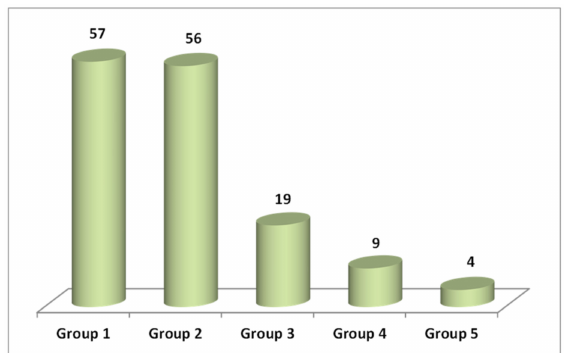
Figure 3. Number of cities of each